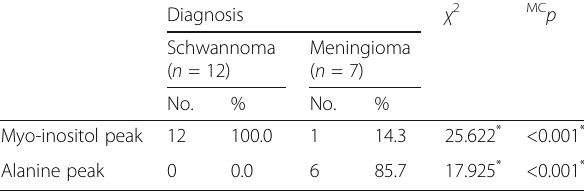
Table 5 Comparison of myo-inositol and alanine peaks on MRS between meningiomas and schwannomas